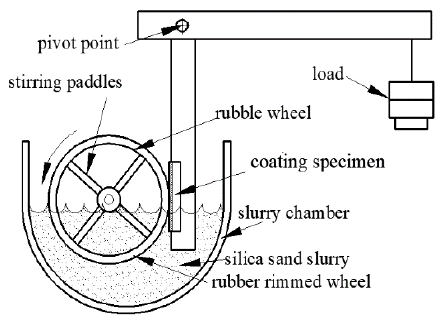
Figure 3. Schematic diagram of the three-body abrasive wear test apparatus.